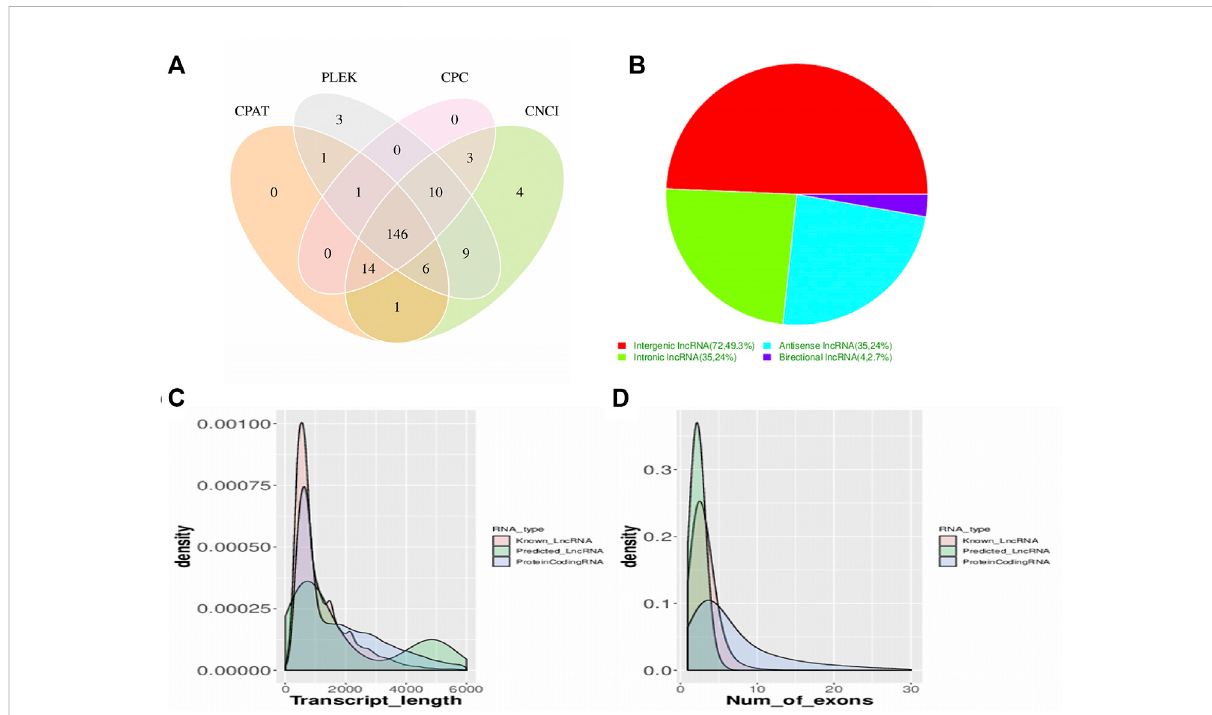
FIGURE 2 Screening and classi fi cation of thecandidate long noncoding RNAs (lncRNAs) in mice trigeminal ganglion transcriptome. (A) a Venn diagram of coding potential analysis according to strict criteria. Four tools (CPC, CNCI, PFAM, and PhyloCSF) were used to analyze the coding potential of lncRNAs. Those simultaneously shared by four analytical tools were designated as candidate lncRNAs and used in subsequent analyses. (B) . classi fi cation of the four subtypes of lncRNAs. (C) . the distribution of transcript lengths in the mRNAs and lncRNAs are displayed, the horizontal axis of indicates the length of transcripts, and the vertical axis represents density. (D) . the number of exons in the mRNAs and lncRNAs are